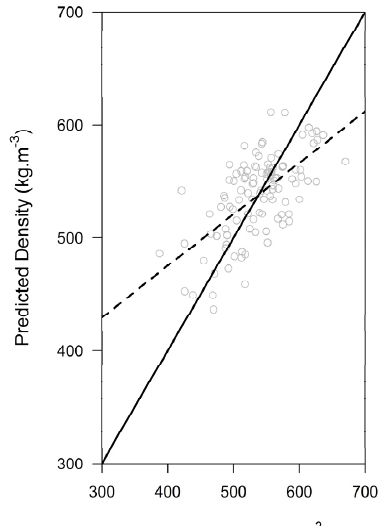
Figure 5. Actual versus predicted wood density in the fitting data set. Dashed line is the line of best fit; solid line represents a 1:1 correspondence.